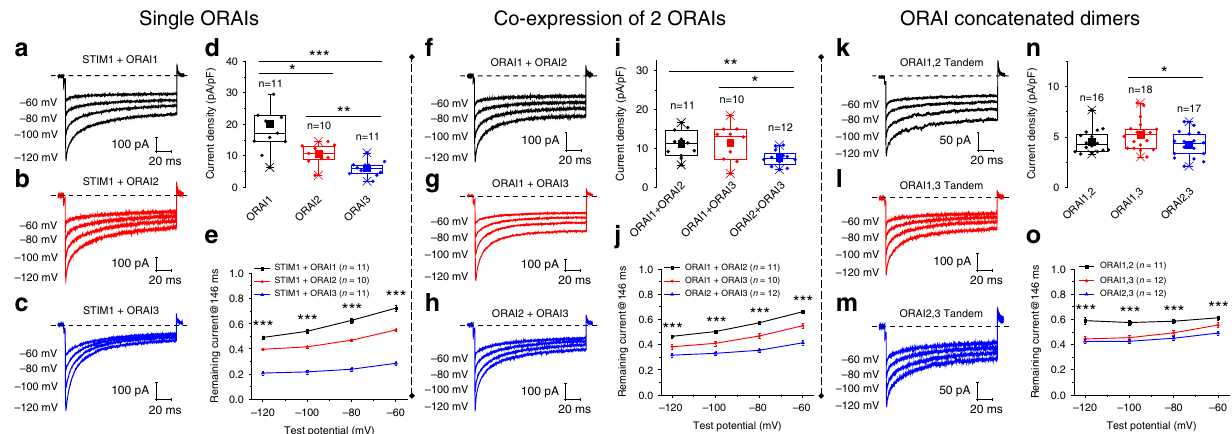
Fig. 4 ORAI isoforms form heteromeric channels. a – c Representative currents were recorded with a pipette solution containing 10 mM EGTA and elicited by hyperpolarizing voltage steps (holding potential + 30 mV) from ORAI-TKO cells co-expressing YFP-STIM1 (4 µ g plasmid) with individual CFP-ORAI isoforms (1 µ g plasmid). d , e Peak current densities at − 100 mV are shown in d and the extent of ORAI isoform CDI represented as current remaining at 146 ms are shown in e ; each data point represents mean ± SEM. f , g Representative currents were recorded with a pipette solution containing 10 mM EGTA and elicited by hyperpolarizing voltage steps (holding potential + 30 mV) from ORAI-TKO cells co-expressing YFP-STIM1 (4 µ g plasmid) with two CFP- ORAI isoforms (0.5 µ g plasmid each). i , j Peak current densities at − 100 mV are shown in i and the extent of CDI of ORAI isoform combinations are represented as current remaining at 146 ms and shown in j ; each data point represents mean ± SEM. k – m Representative currents were recorded with a pipette solution containing 10 mM EGTA and elicited by hyperpolarizing voltage steps (holding potential + 30 mV) from ORAI-TKO cells co-expressing YFP-STIM1 (4 µ g plasmid) with 1 µ g plasmid of concatenated ORAI isoform heterodimers C-terminally tagged with tdTomato (e.g., ORAI1,2 Tandem). n , o Peak current densities at − 100 mV are shown in n and the extent of CDI of ORAI concatemers are represented as current remaining at 146 ms and shown in o ; each data point represents mean ± SEM. All data were statistically analyzed using one-way ANOVA with multiple comparisons (* p < 0.05; ** p < 0.01; *** p < 0.001; **** p < 0.0001). Comparisons deemed signi fi cant are indicated by horizontal bars. Boxplots show the mean, median, and the 75th to 25th